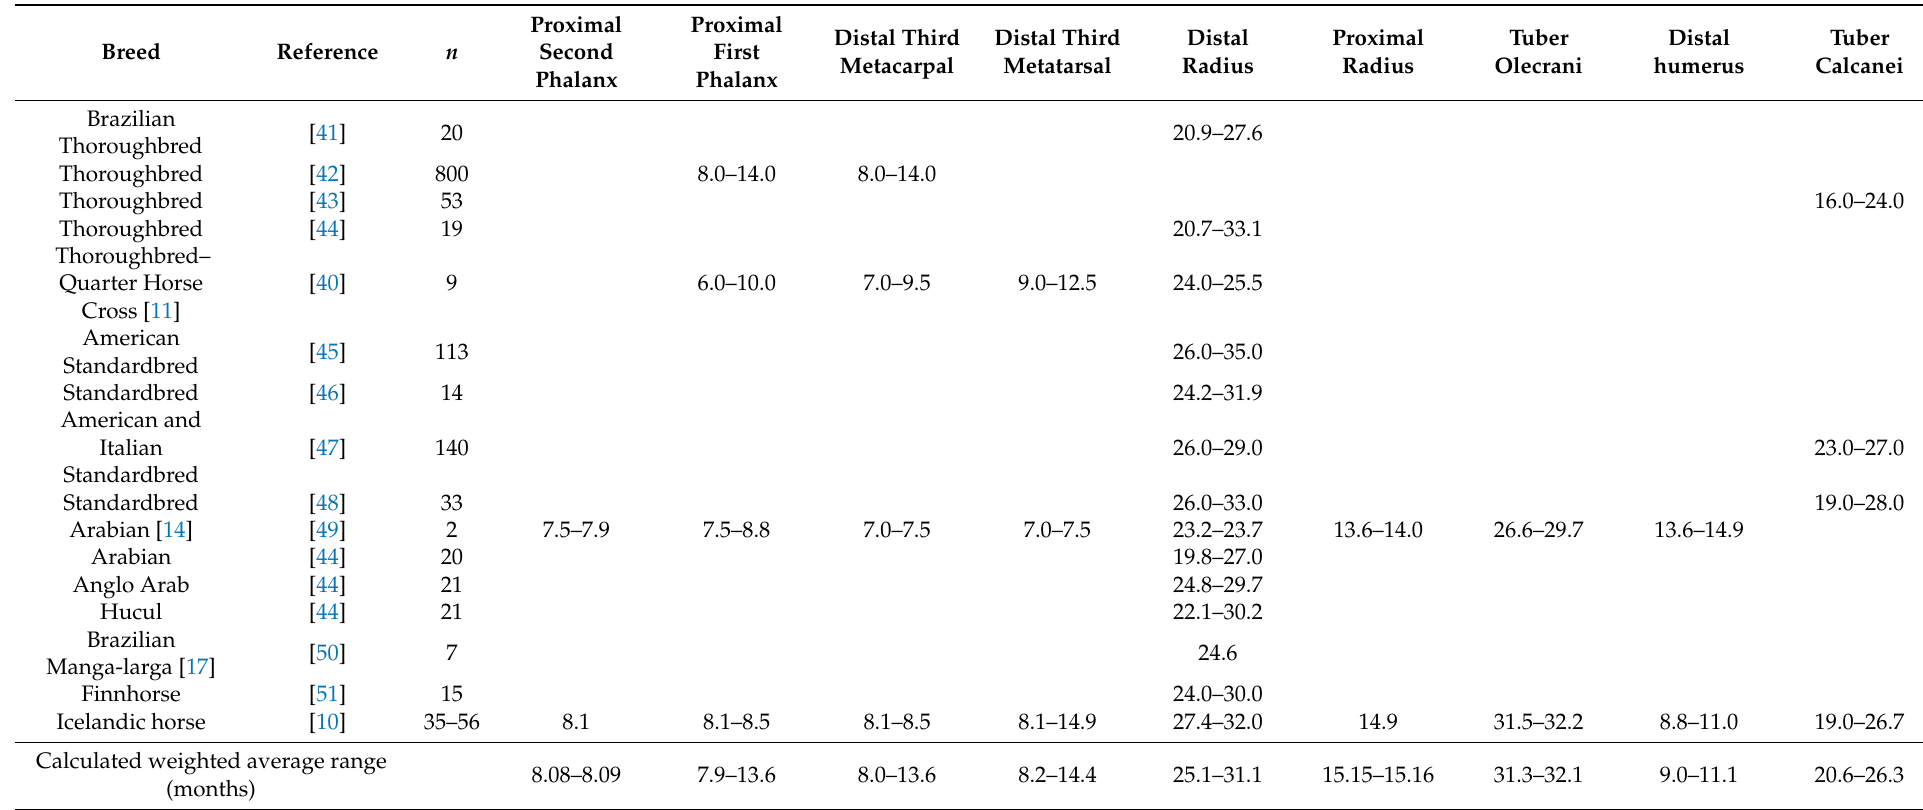
Table 1. Radiographically reported closure of growth plates in the horses limb and weighted average estimate of age (months) of physeal closure for anatomical sites in the limb: modified from